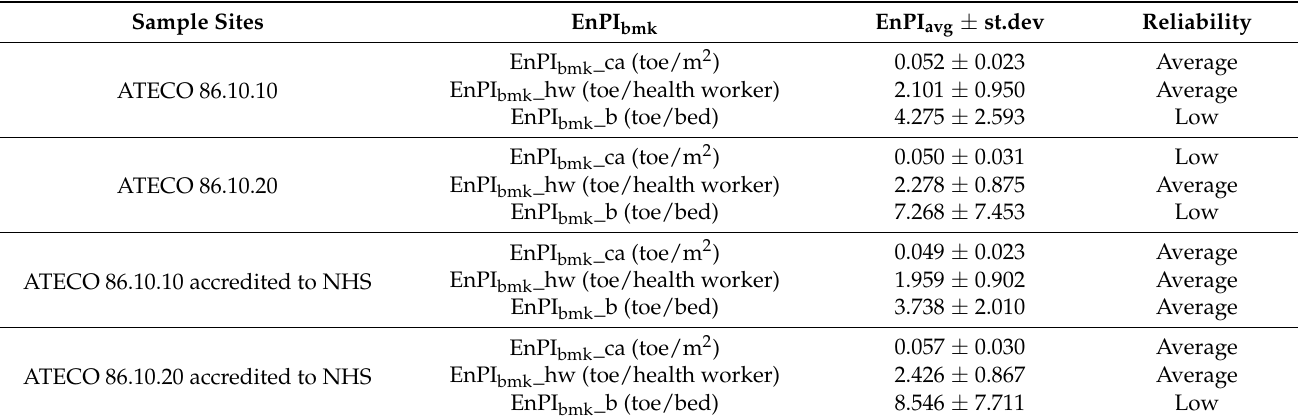
Table 2. Results of the EnPIs